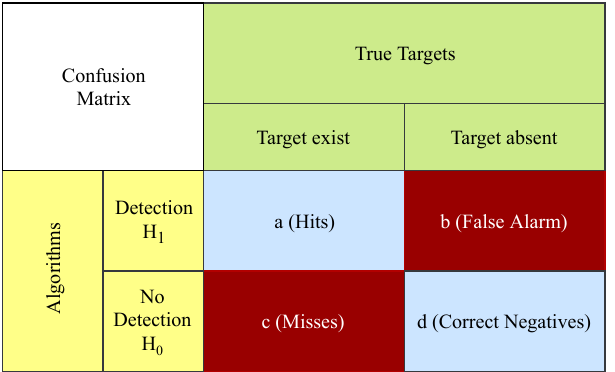
Figure 7. The structure of the confusion